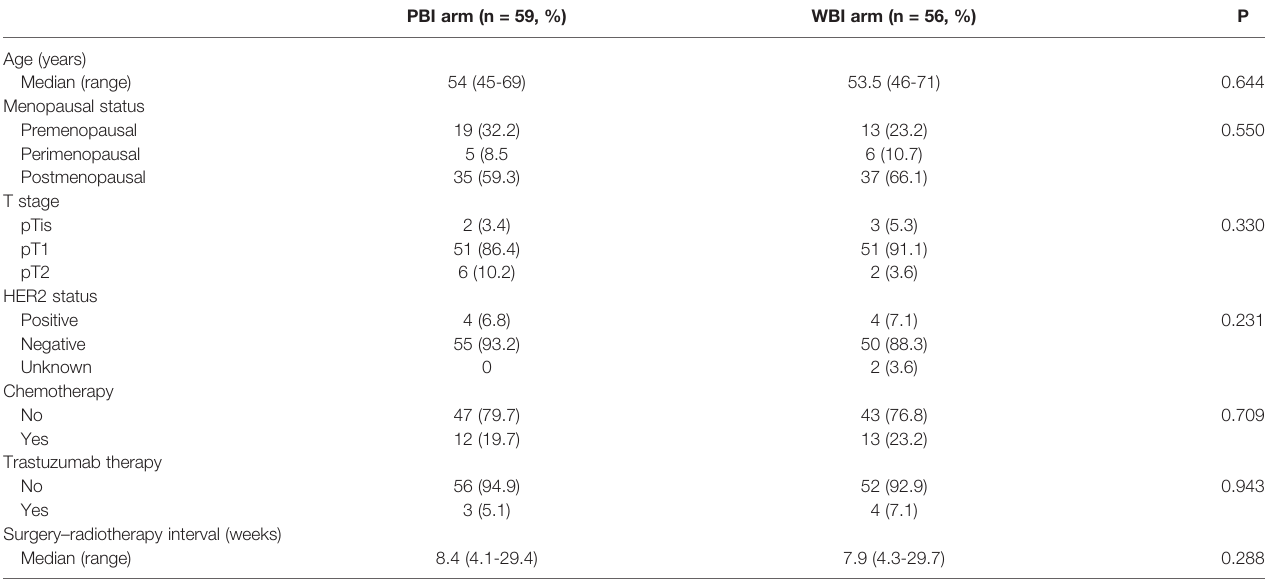
TABLE 1 | Clinical characteristics and treatments between the PBI and WBI